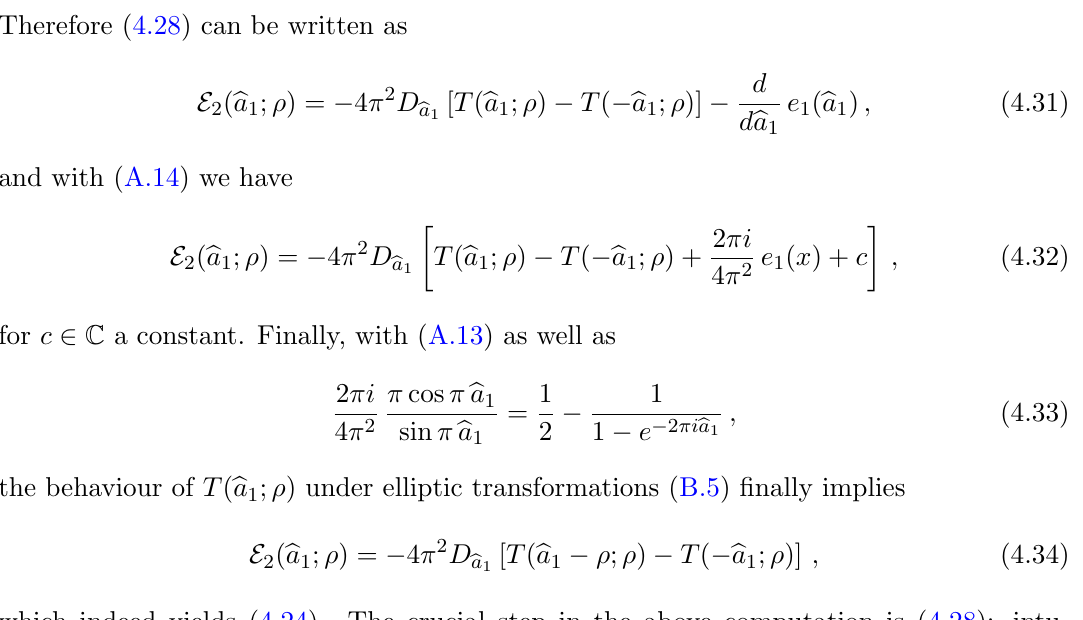
Figure 2 . (a) Summation over the whole lattice W , shifted by summation in three parts according to the (cid:12)rst line of (4.28): the green points correspond to the summation over n 2 Z in the (cid:12)rst term, while the blue and orange points are summed over in the second and third term